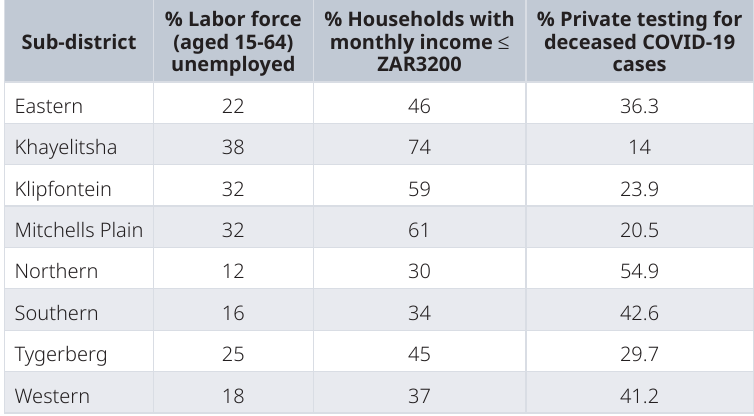
Table 2. Economic indicators (taken from 2011 Census 3 ) and test facility for deceased COVID-19 cases, by sub-district.